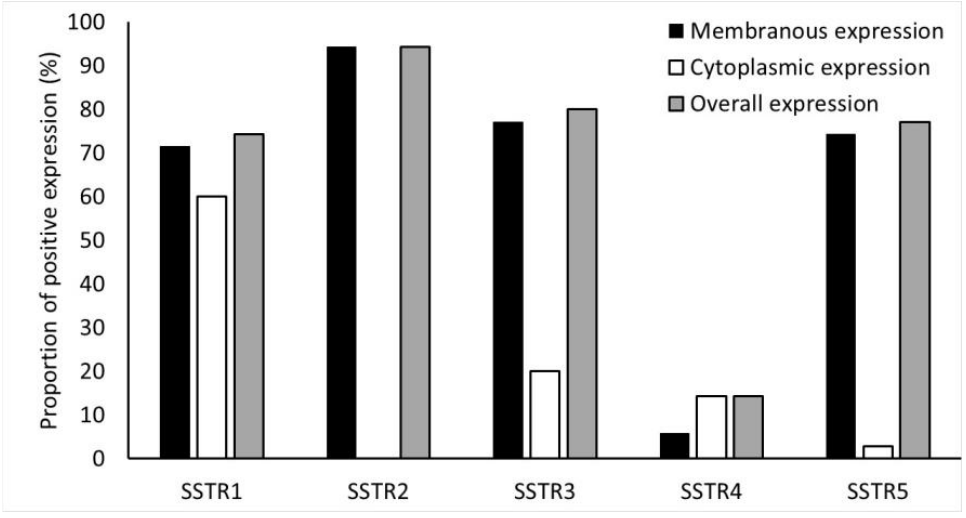
Figure 4. Frequency (%) of SSTR1-5 expressions in the tumors. SSTR2 staining was completely membranous. There was a correlation between positive/negative [ 68 Ga]Ga-DOTANOC and immuno- histochemical SSTR2 expression (Spearman’s rho − 0.382, p = 0.043) (shown in the Table S1). When SSTR2 immunohistochemical expression was scored either positive or negative, all [ 68 Ga]Ga-DOTANOC-avid tumors ( n = 22/23) expressed membranous SSTR2 and the only [ 68 Ga]Ga-DOTANOC-negative tumor did not express membranous SSTR2 (Spear- man’s rho − 1.000, p = 0.043). However, there was no association between SSTR2 expression and uptake intensity of [ 68 Ga]Ga-DOTANOC, expressed as SUVmax (Table S1). SSTR2 expression (positive/negative) correlated with the NETPET score. Of the 14 tumors that expressed SSTR2, 1 had a NETPET score of 1, 6 had a NETPET score of 2, 1 had a NETPET score of 3, 1 had a NETPET score of 4, and the only tumor classified NETPET score of 5 did not express SSTR2 (Spearman’s rho − 0.406, p = 0.043). We also found a correlation between SSTR2 (positive/negative) and the Krenning score. Of the tumors that expressed SSTR2, 9 had a Krenning score of 4, 13 tumors had a Krenning score of 3, and only the tumor with a Krenning score of 2 did not express SSTR2 (Spearman’s rho 0.405, p = 0.043). 3.2. SSTR1, 3, 4, 5 Expression Does Not Correlate with [ 68 Ga]Ga-DOTANOC PET/CT Overall, expression of SSTR1, SSTR3, SSTR4, and SSTR5 were detected in 74%, 80%, 14%, and 77% of NF-PNENs, respectively. Details of the membranous, cytoplasmic, and overall expression of SSTR1-5, as described in the methods section, are shown in Figure